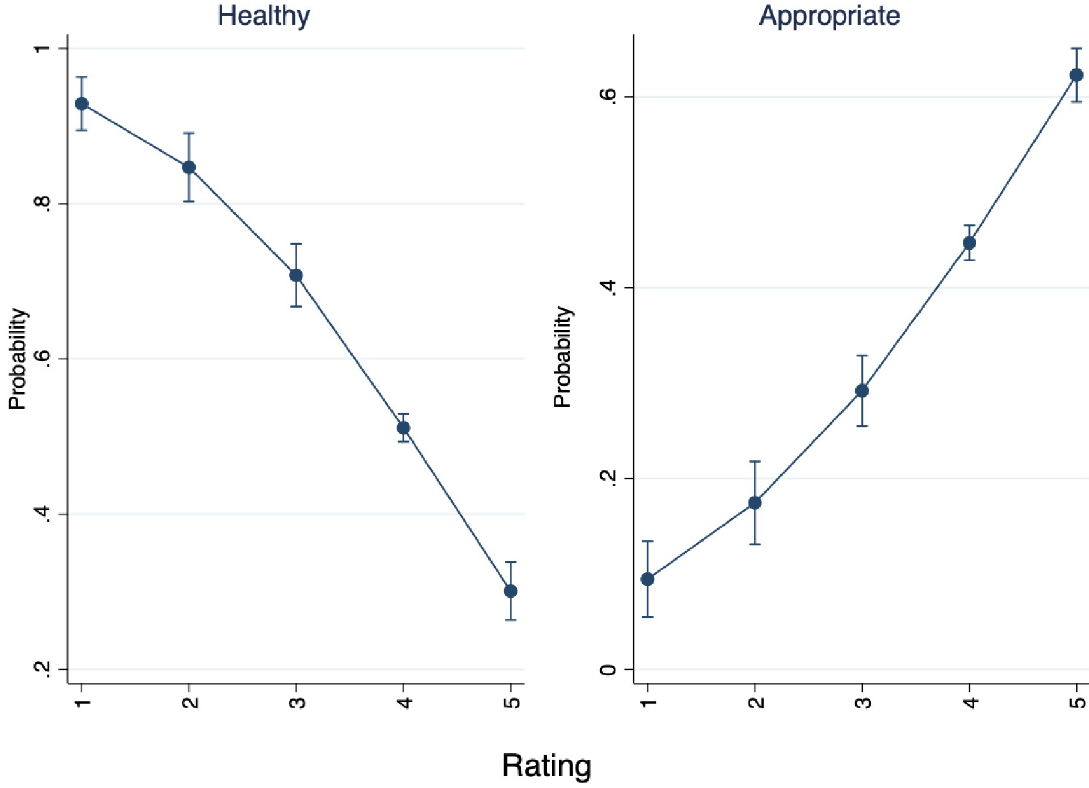
Fig 5. Marginal effects of Western and non-Western audio selections for health and